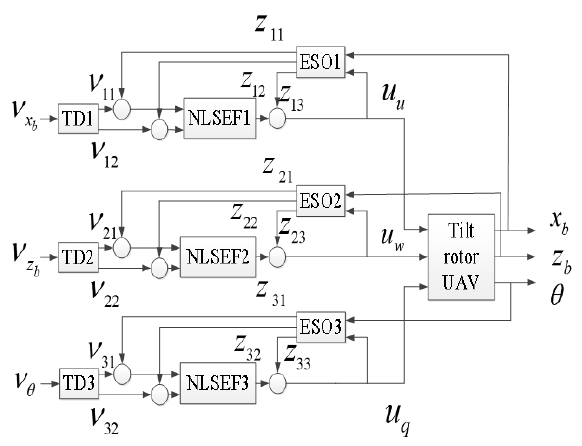
Fig. 2. Structure of longitudinal control system of tilt three-rotor